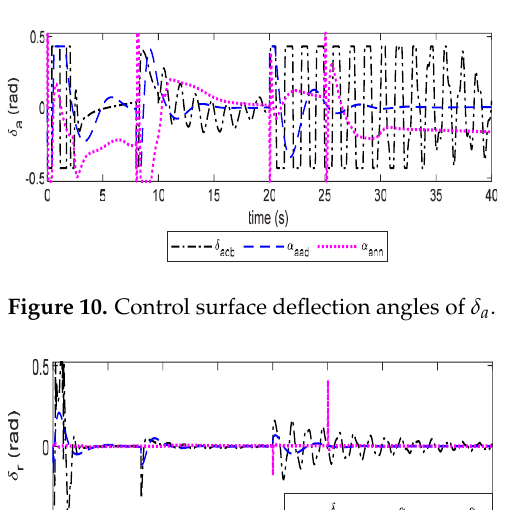
Figure 9. Control surface deflection angles of δ e .